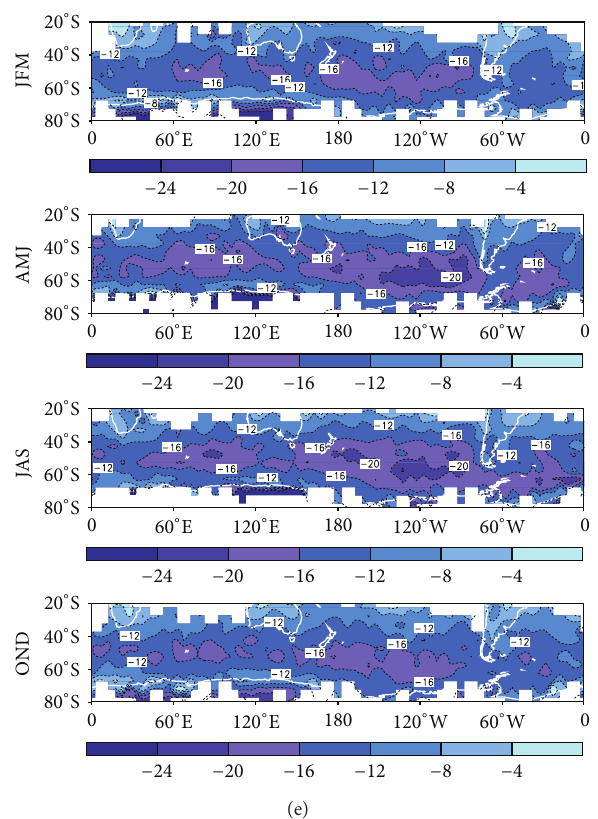
Figure 10: Southern Hemisphere seasonal cyclone track intensity climatology (JFM, AMJ, JAS, and OND) for (a) NCEP1 5801, (b) ERA40 5801, and (c) NCEP2 7910. Intensity calculated relative to seasonal mean sea-level pressure climatology. Units: hPa. (d) NCEP1 7910, (e) NCEP1 5078. Intensity calculated relative to seasonal mean sea-level pressure climatology. Units: hPa.